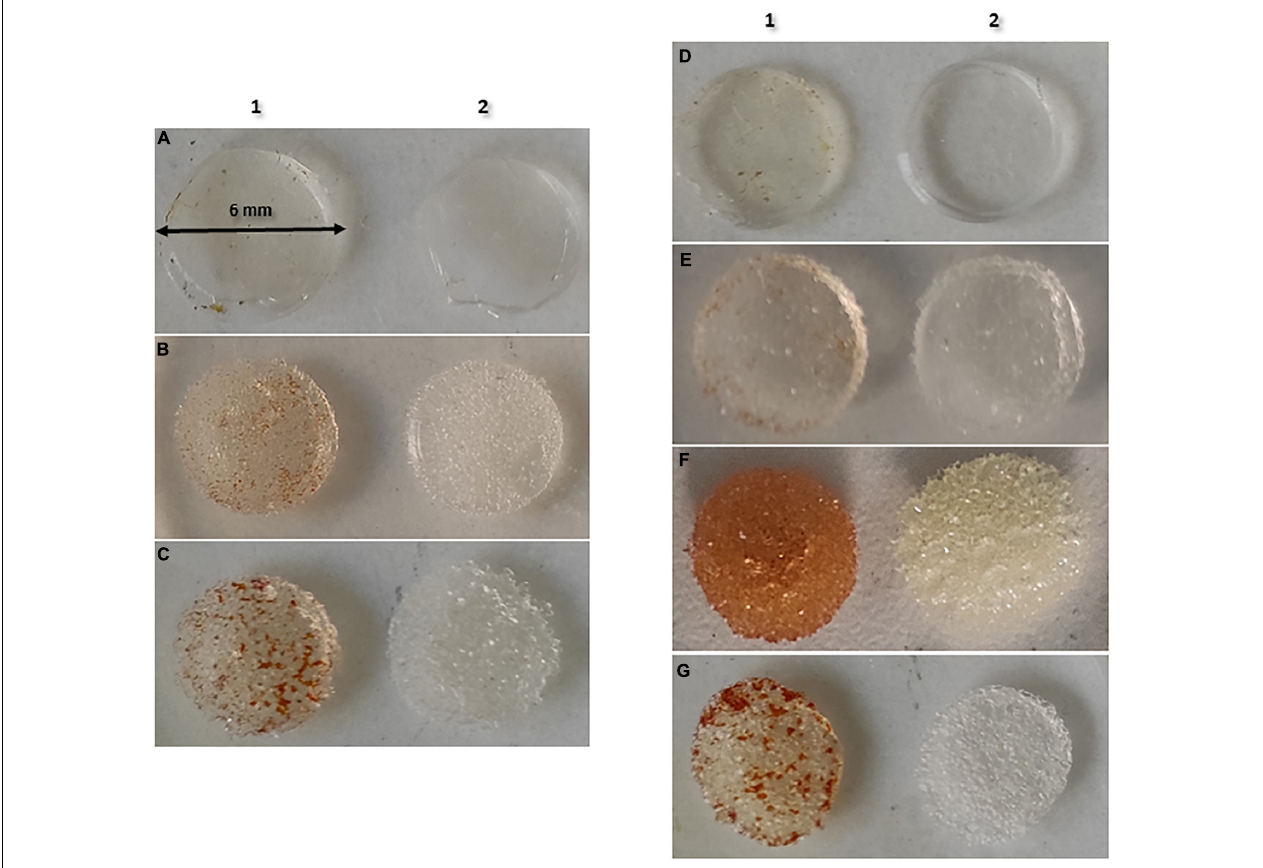
FIGURE 4 | Absorption of PI in each type of implant. (A) Mentor R (cid:13) smooth (10 µ m); (B) Mentor R (cid:13) SiltexTM (28 µ m); (C) Mentor R (cid:13) CPGTM (36 µ m); (D) Polytech R (cid:13) PolysmoothTM ( < 10 µ m); (E) Polytech R (cid:13) MESMO R (cid:13) (25 µ m); (F) Polytech R (cid:13) Polytxt R (cid:13) (25–50 µ m); (G) Polytech R (cid:13) macrotextured (50–100 µ m). 1 , povidone iodine; 2 ,